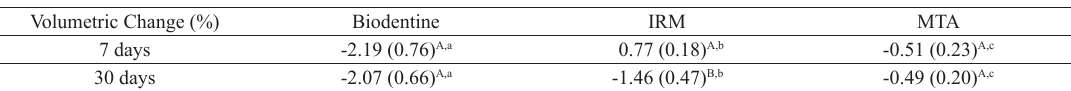
Table 3. Volumetric change values (%) after 7 and 30 days (mean and standard deviation) observed in endodontic cements Volumetric Change (%)